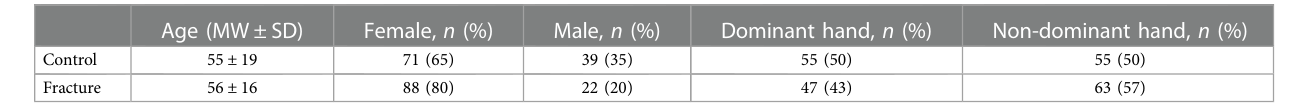
TABLE 1 Epidemiological and demographic data of control and study